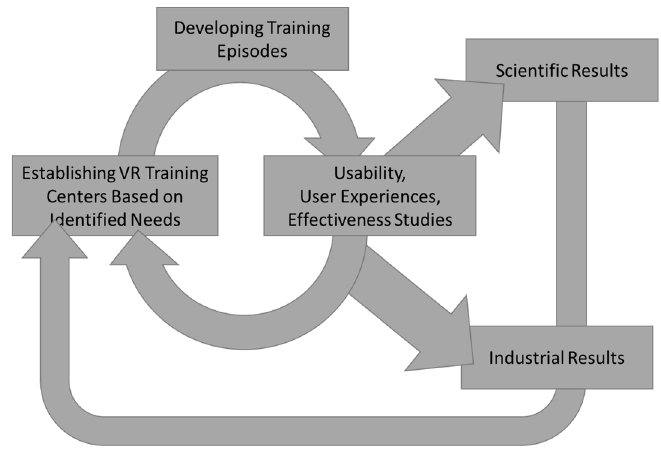
Figure 2. The research design in this study.